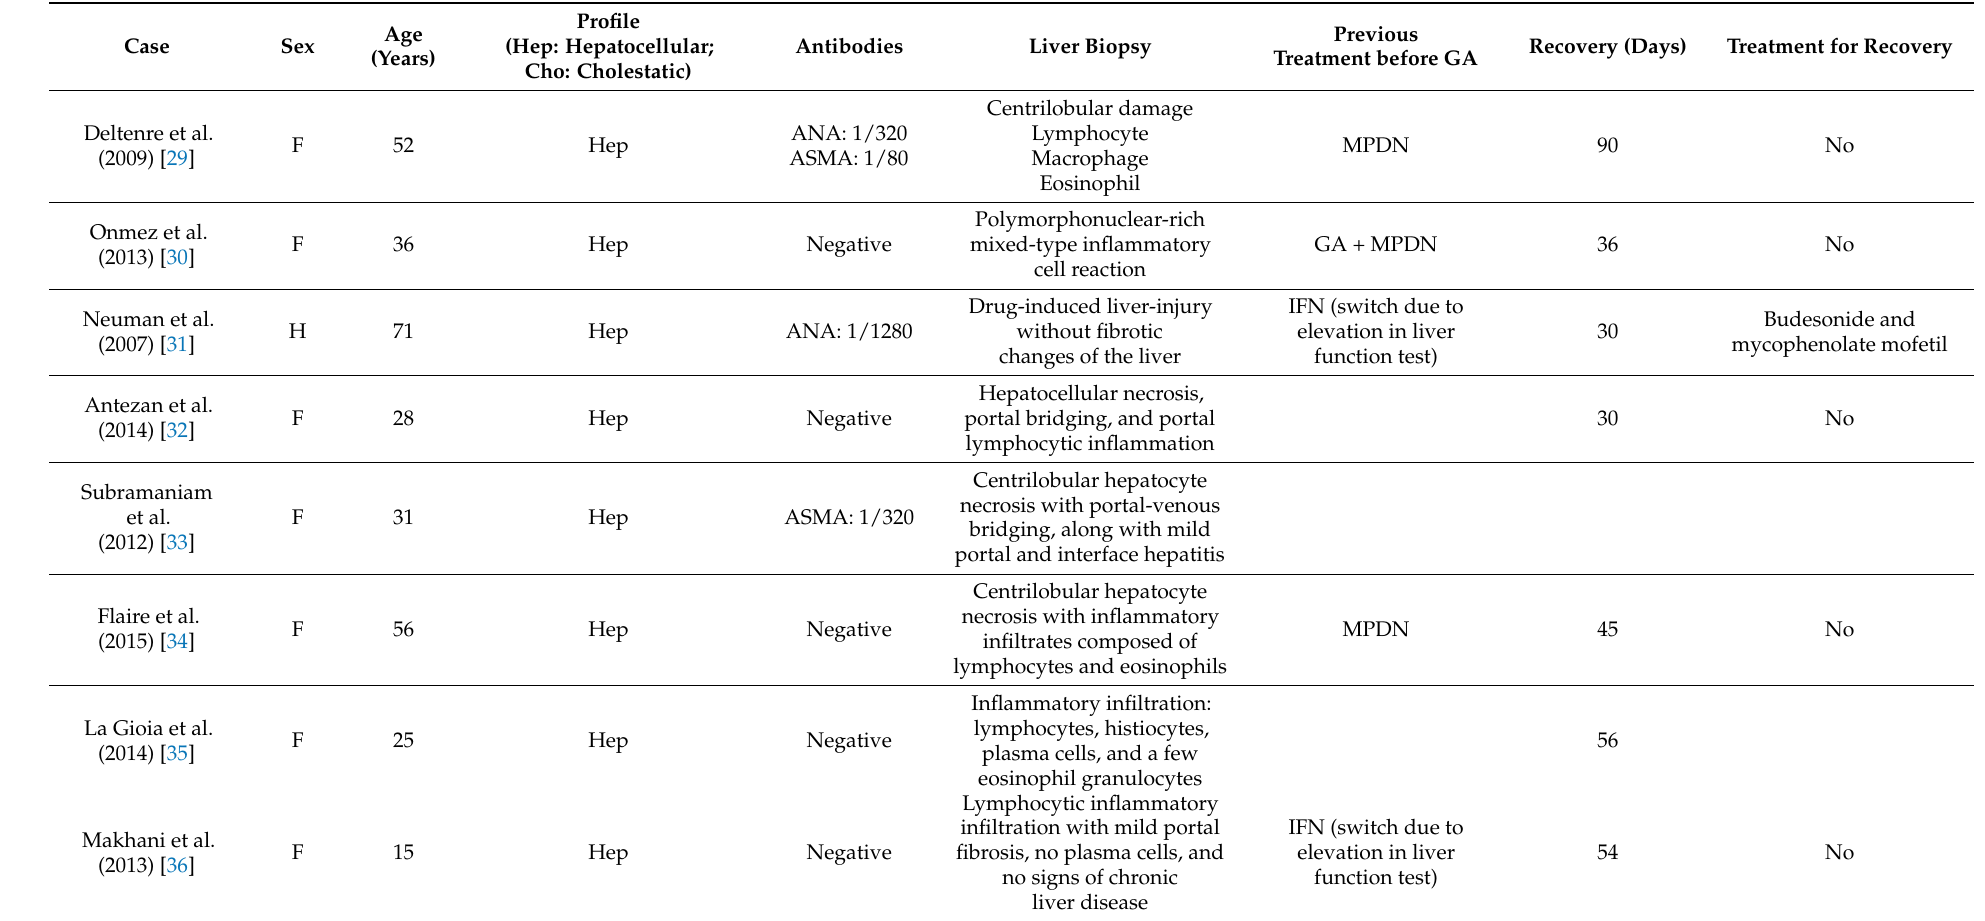
Table 2. Cases of glatiramer acetete (GA)-associated liver